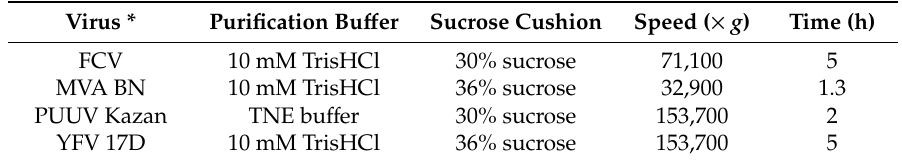
Table A2. Purification conditions of the applied viruses.